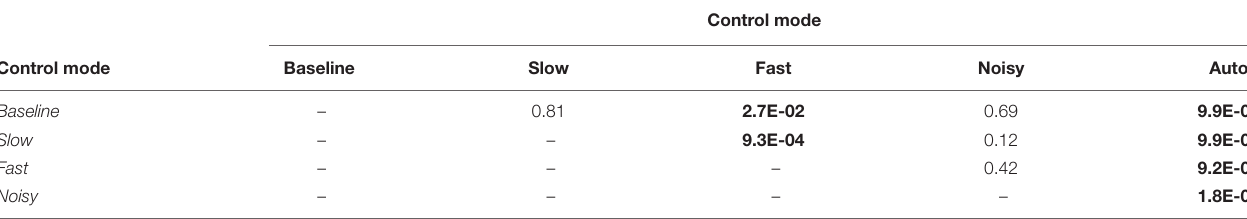
TABLE 3B | Post hoc comparisons ( p -value) between control modes for smoothness.